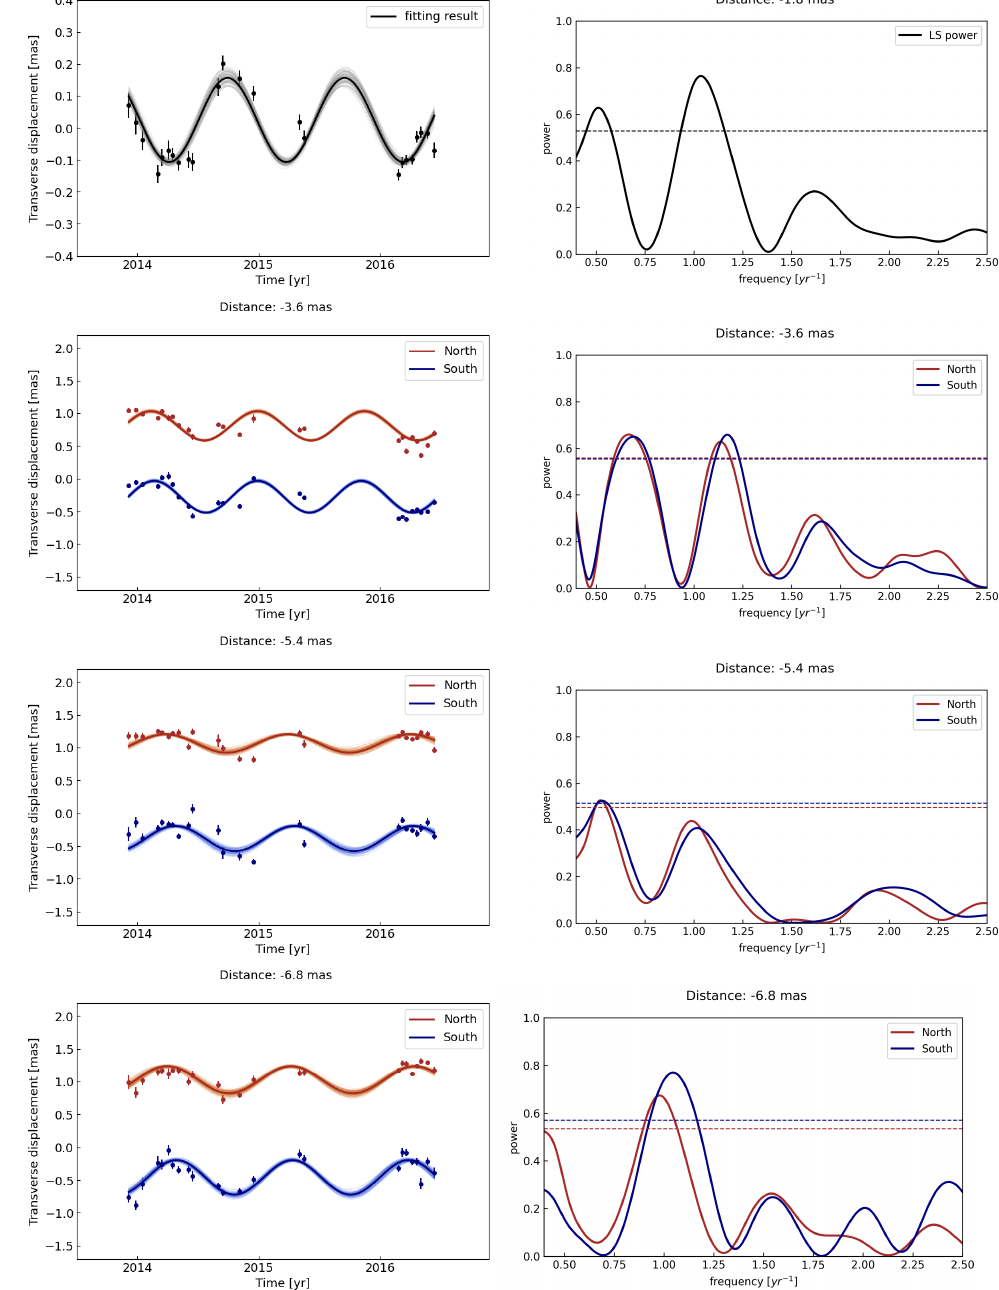
Figure 3. ( Left ) Transverse oscillations of the M87 jet obtained at 1.8, 3.6, 5.4, and 6.8mas from the core from December 2013 to June 2016. The filled circle is the transverse displacement of the jet ridge from the jet axis. The thick line is the best-fit sinusoidal model. The thin lines are 100 randomly chosen model parameters from the MCMC samples to show the statistical errors. The black line is the result of the single ridge and the red and blue lines are the result of the northern and southern ridges, respectively. The amplitude ( A ), period ( P ), phase ( φ ), and offset ( y 0 ) of the sinusoidal fit are summarized in Table 1. ( Right ) Lomb–Scargle periodogram results of the transverse oscillations of the M87 jet at the same locations. The dashed horizontal line is the false alarm probability of 10% with an assumption of white